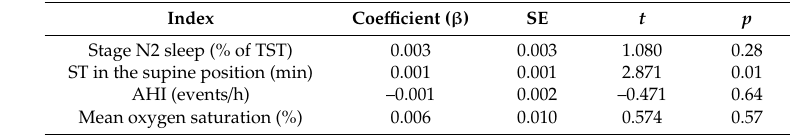
Table 3. Multiple linear regression analysis of significant factors in univariate analysis.